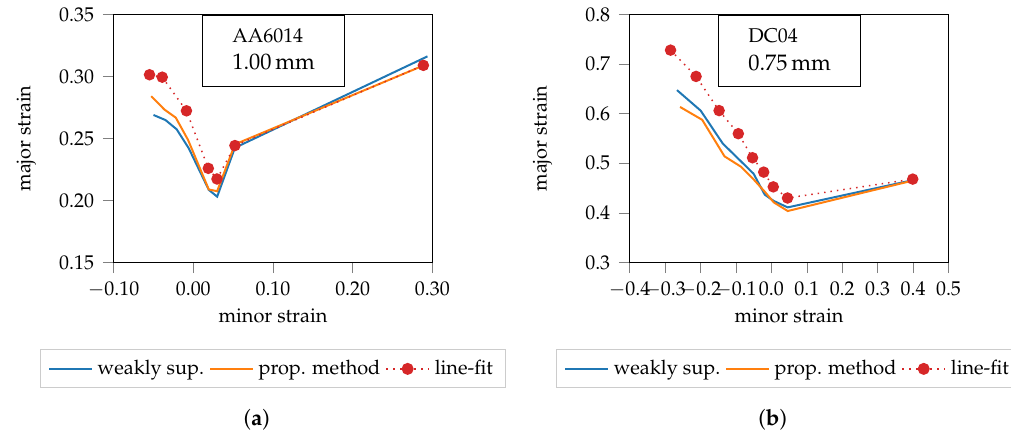
Figure 8. Comparison of the weakly supervised approach and the proposed method. ( a ) AA6014 FLC candidates. ( b ) DC04 FLC